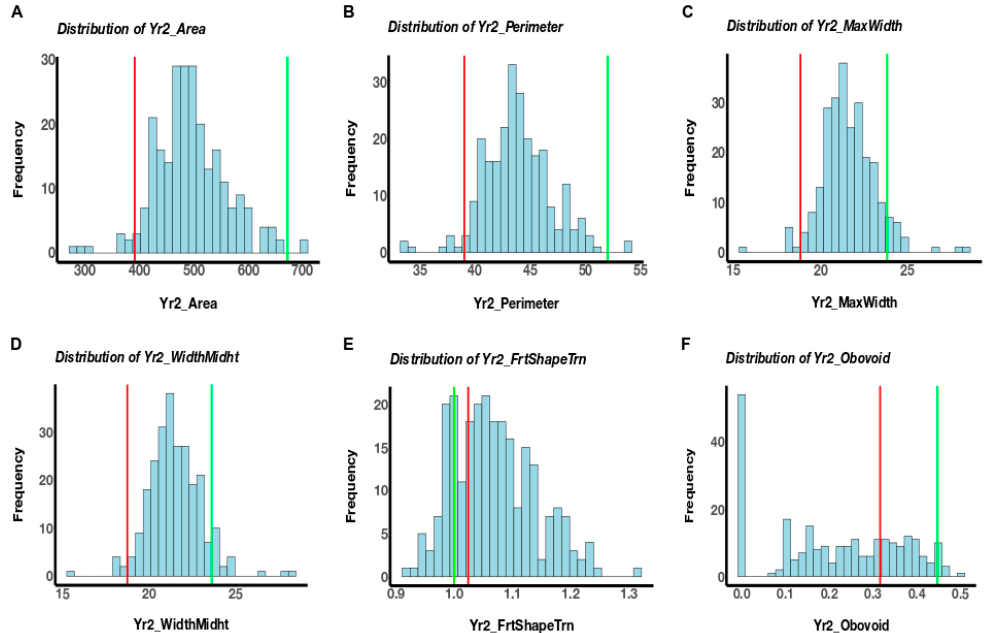
Figure 3. Phenotypic distribution of raw data for the area ( A ), perimeter ( B ), maximum width ( C ), width mid-height ( D ), fruit shape triangle ( E ), and obovoid ( F ) in the NC 10204 population in F5:6 generation. Data were square root transformed for all traits. Lines were assessed using Tomato Analyzer software. The red bar indicates LSMEAN of parent NC 22L-1(2008), and the green bar indicates LSMEAN of parent NC 30P.